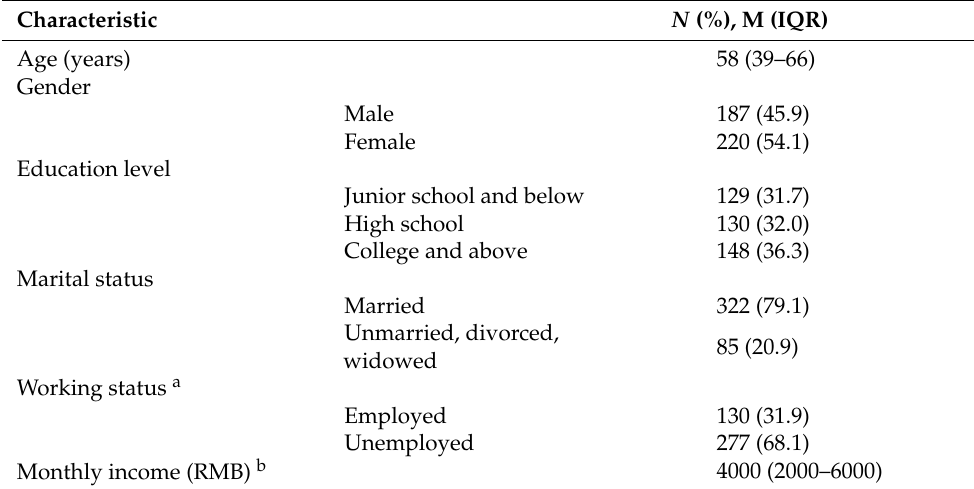
Table 2. Demographic characteristics of the participants (N =